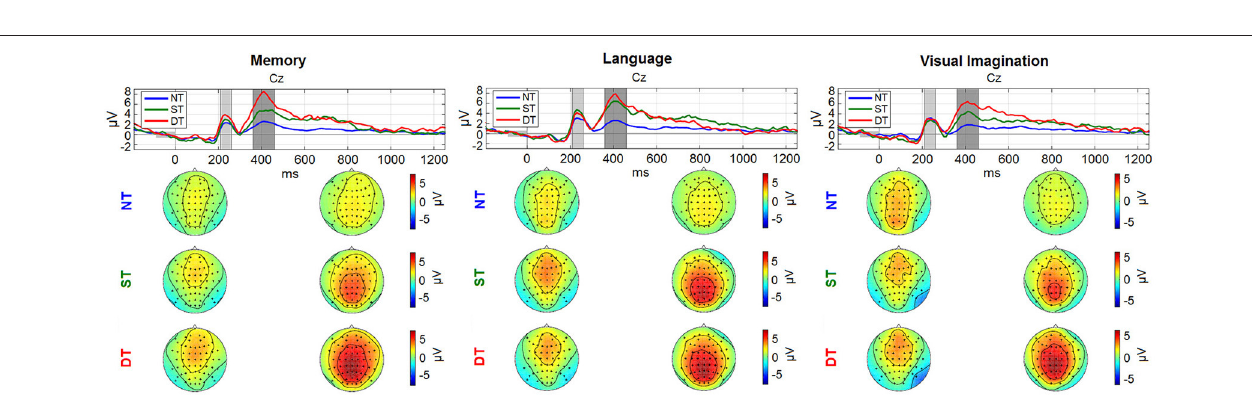
FIGURE 5 | Behavioral assessment indicators: answers ratio (left) and difficulty scores (right) for the three cognitive processes (memory—dark gray, language—light red, visual imagination–light gray). The upper and bottom whiskers of each box-plot corresponds to the maximum and minimum values over all participants. The horizontal sides of the rectangular boxes represent the 25 and 75% percentiles of the data. The mean values are represented by the blue asterisk (*) and the outliers are indicated by the red crosses. Left plot of answers ratio is taken from Nicolae et al. (2015b) with permission from Springer.